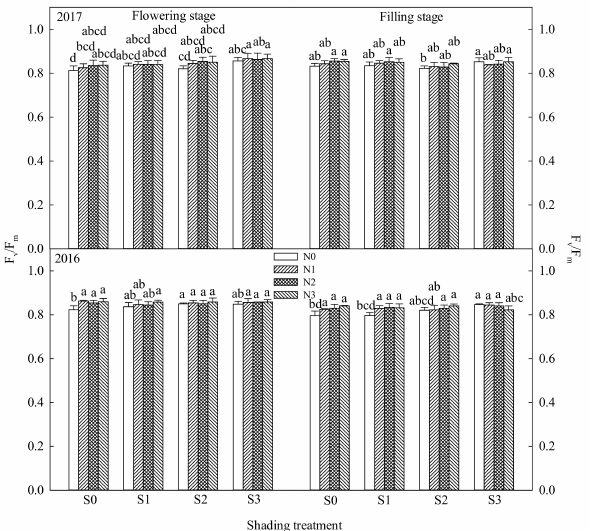
Figure 6. Effect of light and nitrogen treatment on maximum quantum efficiency of PSII photochem- istry (Fv/Fm) of wheat. Bars indicate SD (n = 3). Values within columns followed by the same letter are statistically in-significant at the 0.05